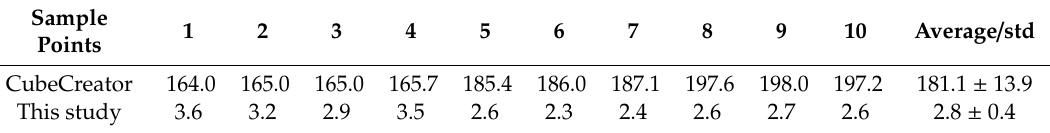
Table 3. Comparison of the alignment error (pixels) using both CubeCreator and the algorithm developed in this